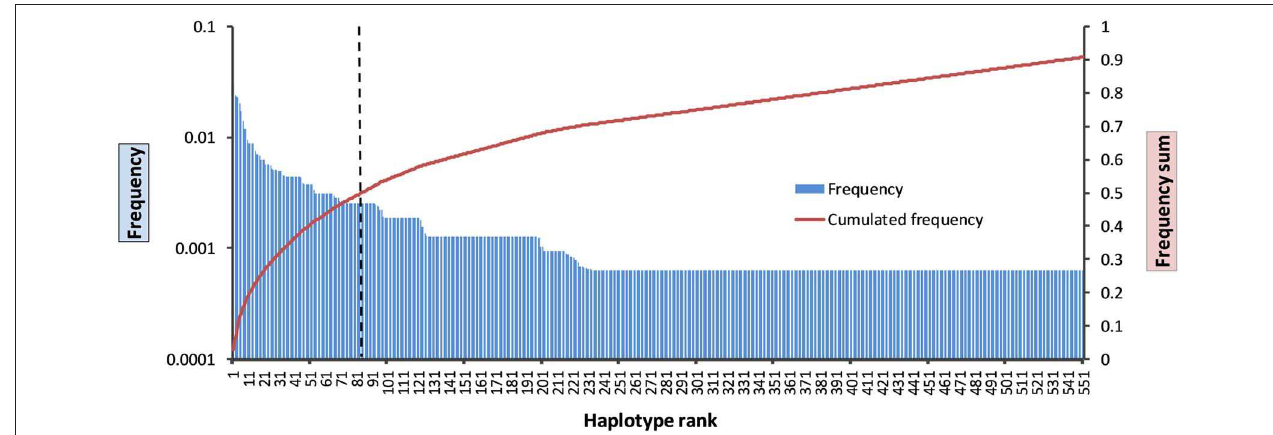
FIGURE 2 | Frequency distribution of the 551 allele group KIR haplotypes above the resolution threshold of f = 1/2 n . Blue bars: haplotype frequencies; red line: cumulated frequency; dashed black line: haplotype rank 84 with 50% cumulated haplotype frequency.